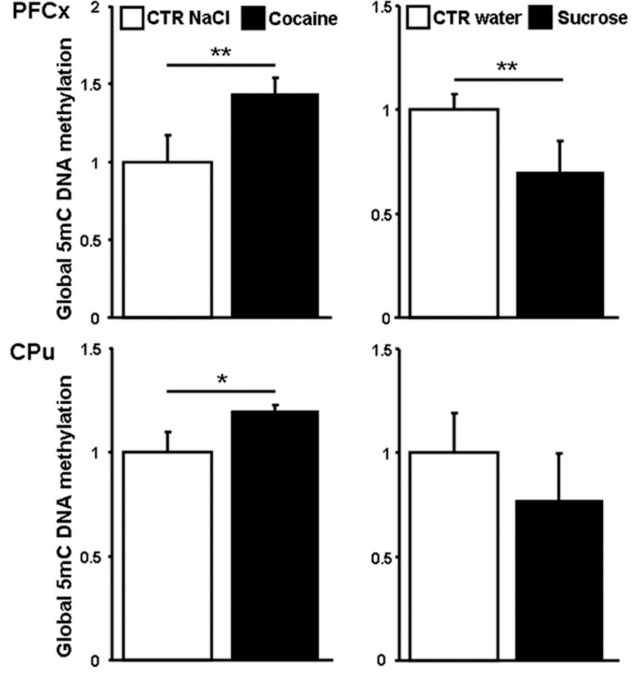
Figure 4. Global 5-methylcytosine analysis in the PFCx and in the CPu. 5mC was measured in response to cocaine and sucrose relative to their controls at ZT16 (15 h after administration). Data represent the mean ± SEM, n = 4 per group. Statistical analysis performed was one-way ANOVA followed by Newman-Keuls post hoc when required. * p < 0.05, ** p <